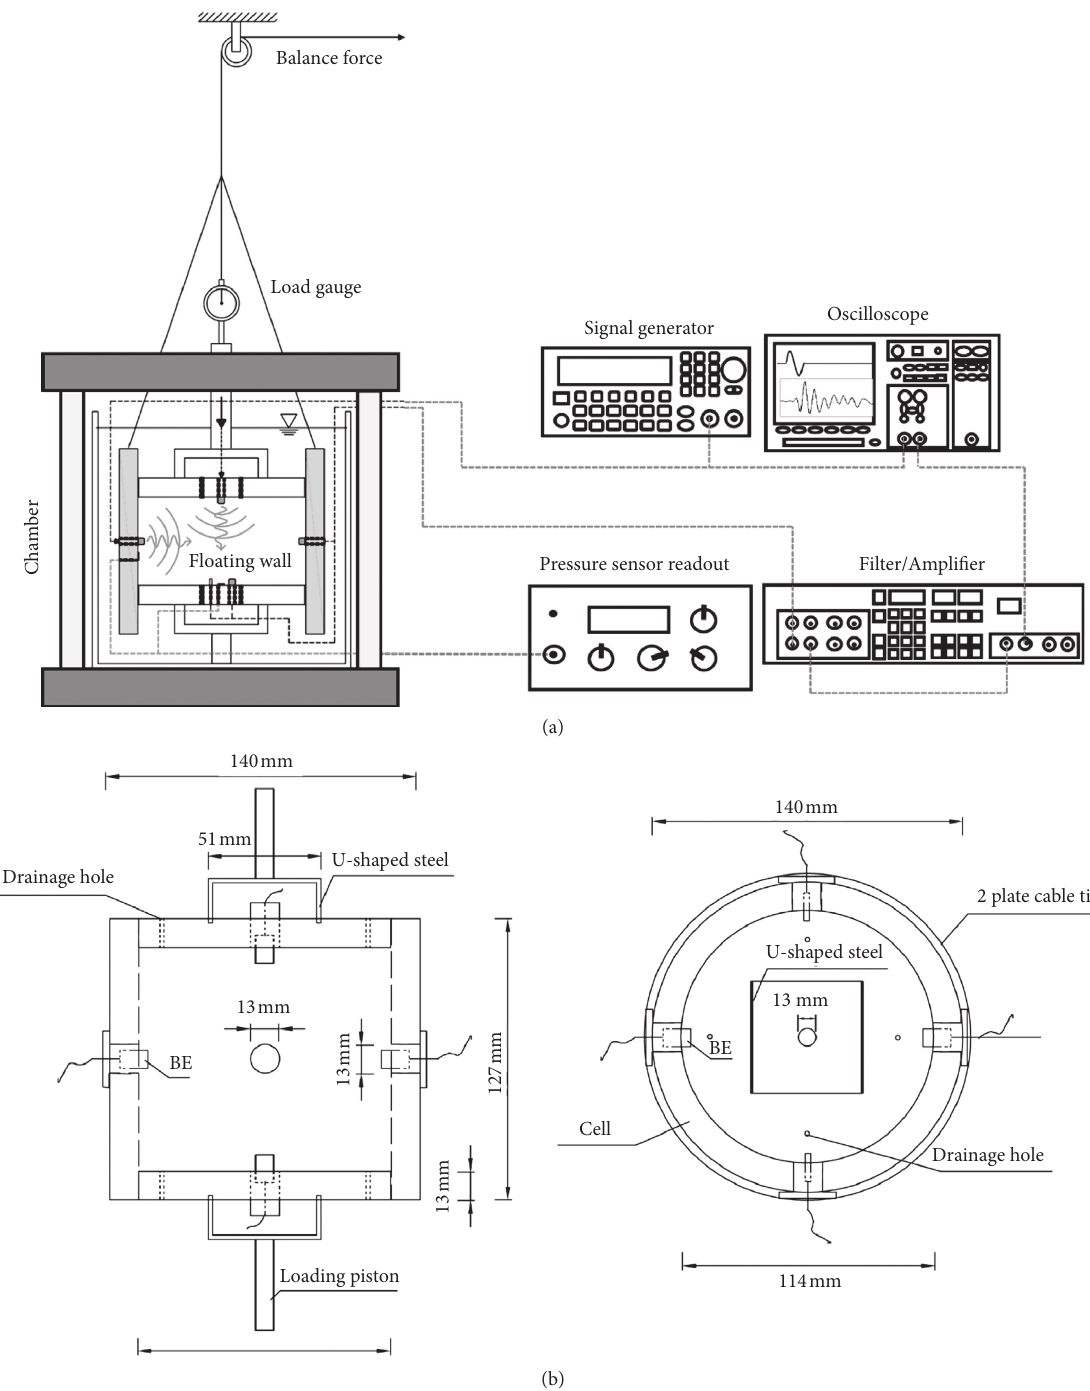
Figure 1: (a) Floating-wall consolidometer-type bender element testing system. (b) The detailed schematic setup of the floating-wall consolidometer cell